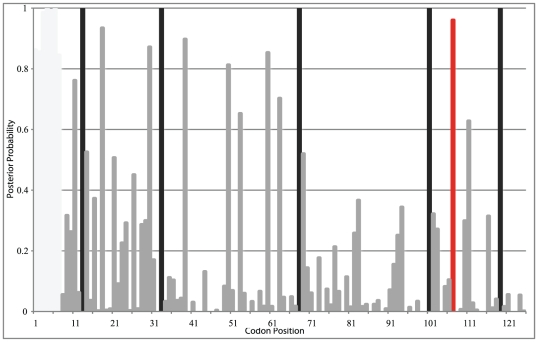
Posterior probabilities for codons estmatied to be under positive selection using OmegaMap [34] implemented with an independent model of rate variation for each site.The dataset used includes 10 Papaver, 11 P. californicus and 11 A. munita sequences. Sites 1–7 from A. munita and P. californicus are excluded because they are not present in Papaver. Codons 13, 33, 68, 103, 119 (black bars) and 107 (red) are predicted to be under positive selection.